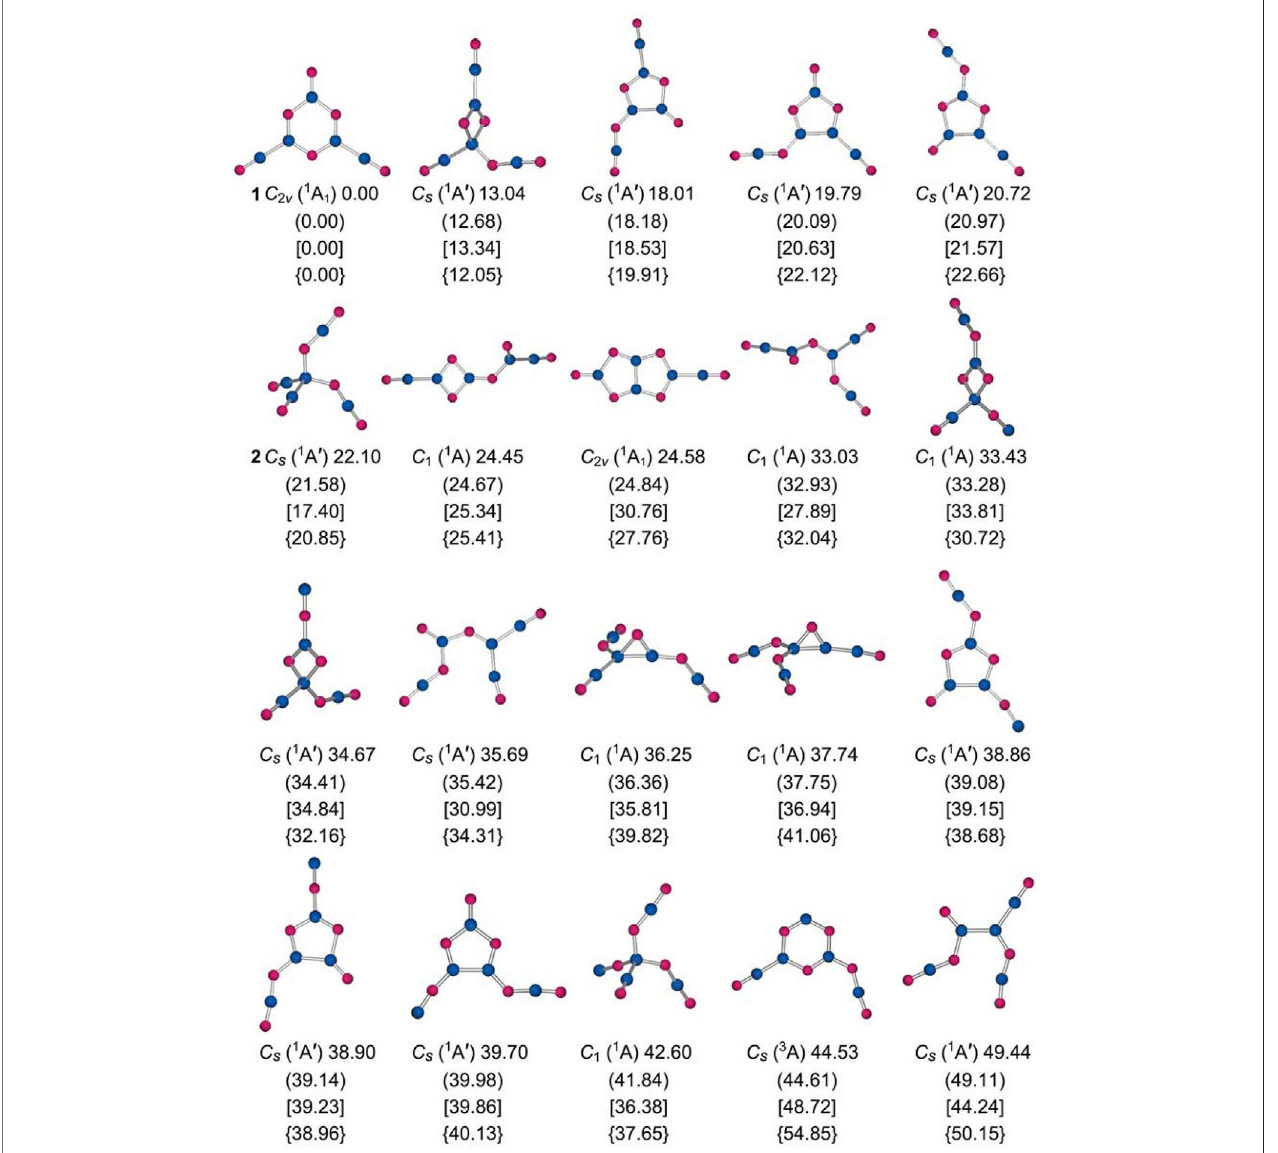
FIGURE 2 | Alternative optimized low-lying isomeric structures of B 5 O 6 − cluster at the PBE0/6-311+G(d) level along with their relative energies (in kcal mol − 1 ), includingzero-pointenergy(ZPE)corrections.TheenergeticsdataarealsopresentedatthePBE0-D3/6-311+G(d)(inbrackets,withZPEcorrections)andB3LYP-D3/6- 311+G(d)(insquarebrackets,withZPEcorrections)levels,aswellasatsingle-pointCCSD(T)/6-311+G(d)levelbasedontheirPBE0-D3/6-311+G(d)geometries(incurly brackets).